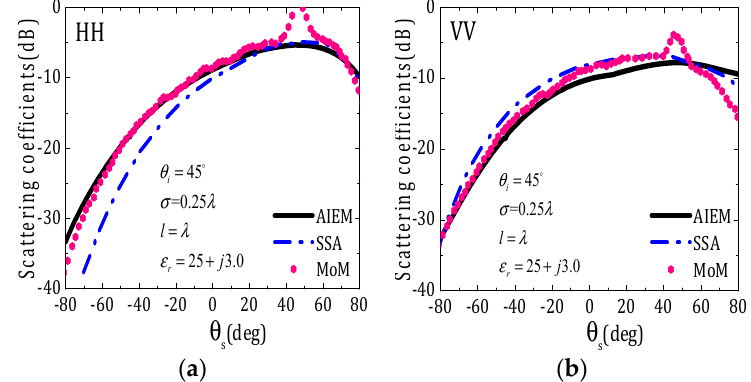
Figure 3. Comparison of bistatic scattering between AIEM prediction and numerical simulations (SSA, MoM) for a dielectric rough surface with a Gaussian-correlated function: ( a ) HH polarization, ( b ) VV polarization.